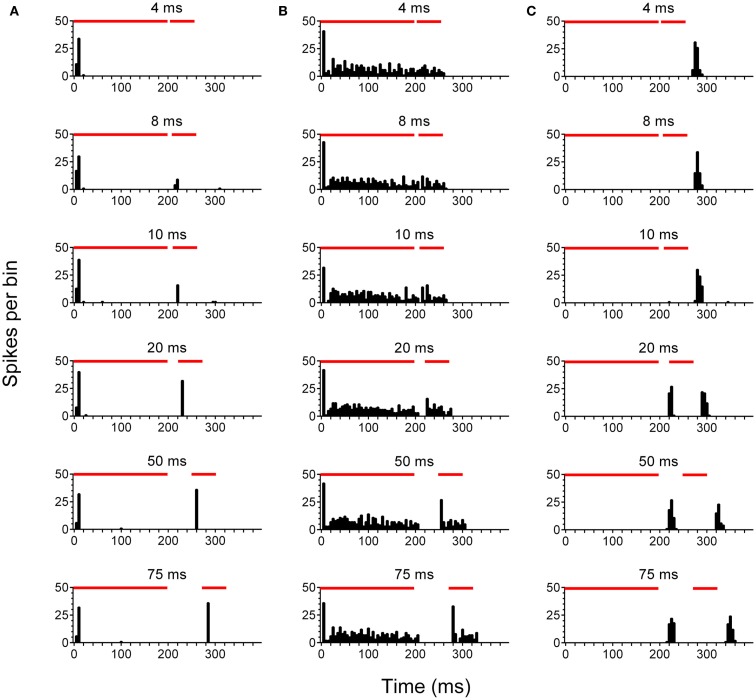
Neuronal activity in the inferior colliculus. Representative examples are shown of onset (A), sustained (B), and offset (C) single-units recorded in the IC. PSTH plots were generated in response to pure tone gap detection stimuli incorporating gaps of varying duration 4, 8, 10, 20, 50, and 75 ms are shown. Red bars indicate the duration of the first 200 ms stimulus, followed by a variable gap, and finally the second 50 ms stimulus.